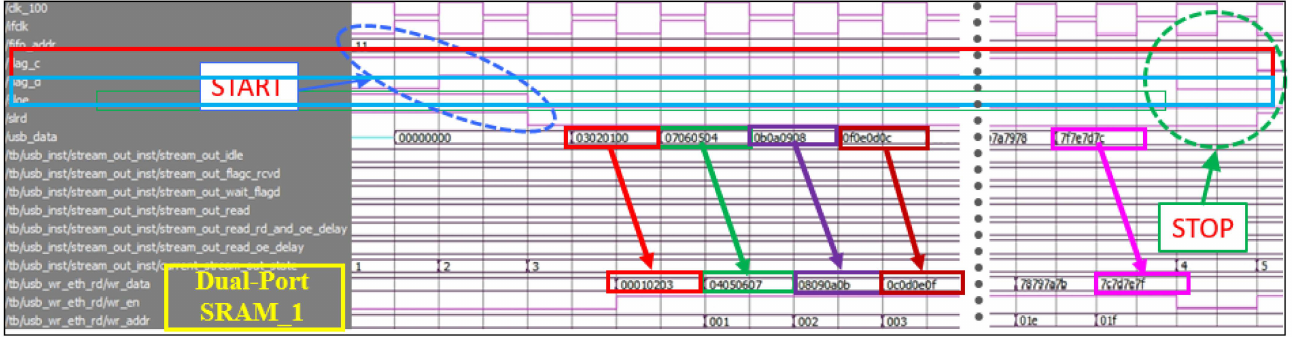
Figure 13. Received USB data in USB module and its serial data in